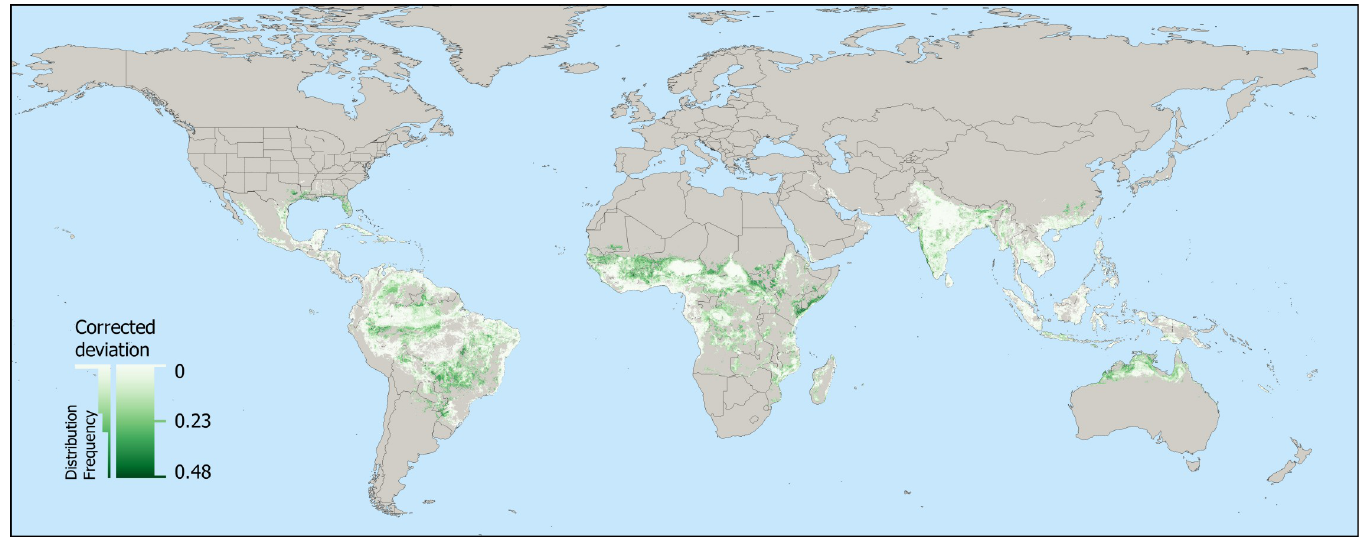
Fig 1. Deviation between Ae . aegypti and dengue environmental suitability. Green indicates areas where Ae . aegypti is likely to be found, but the environment is not considered suitable for dengue transmission (e.g. Southern United States, Northern Argentina, Northern Australia). White indicates areas where the environmental suitability of Ae . aegypti and dengue is similar and higher. Inset histogram provides distribution of the corrected deviation values. The map was created by the author using QGIS 3.10 (https://qgis.org/en/site/) with public domain map data from Natural Earth (https://www.naturalearthdata.com/downloads/50m-physical-vectors/) and U.S. Geological Survey (https://woodshole.er.usgs.gov/pubs/of2005-1071/data/background/us_bnds/state_boundsmeta.htm).